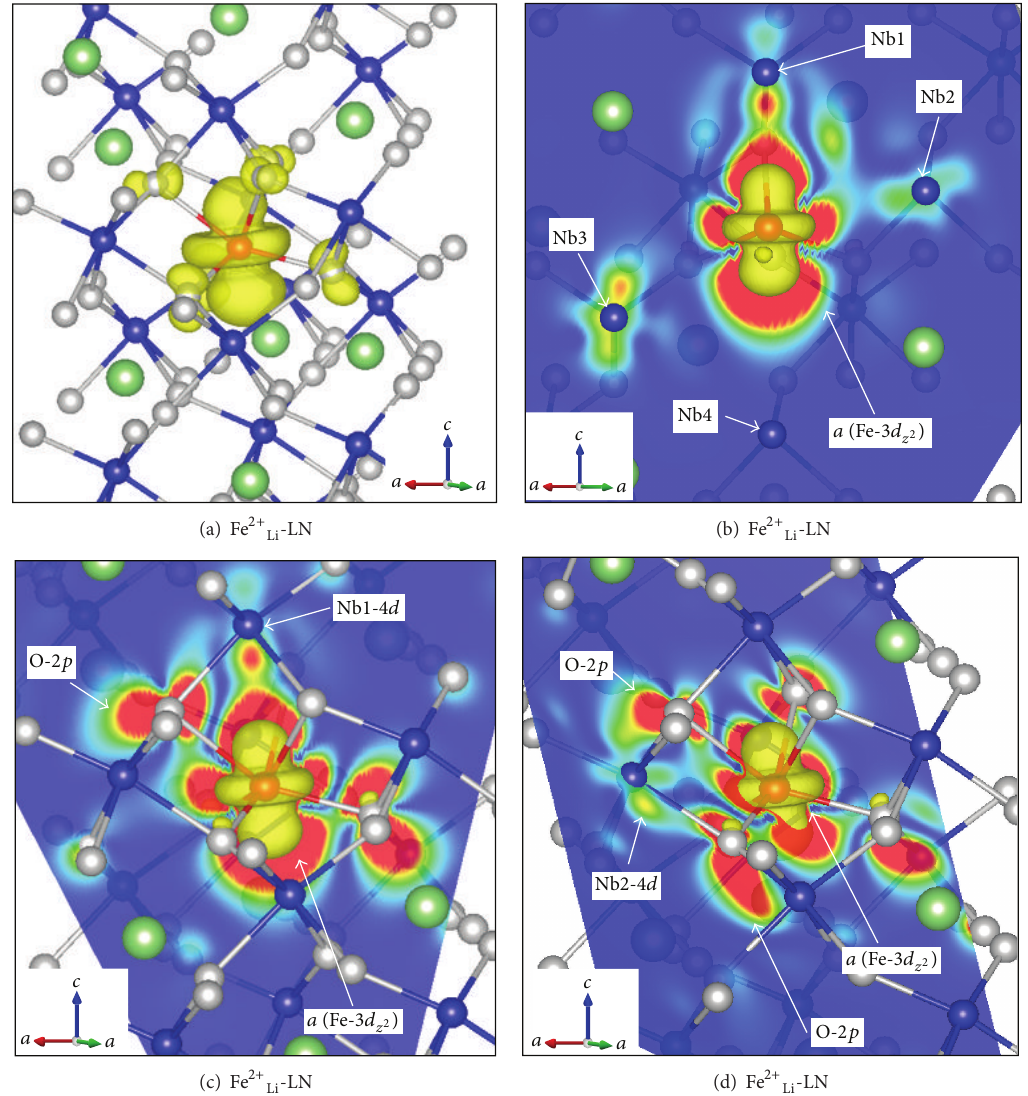
Figure 4: Wave functions of the occupied 𝑎 state in the minority spin ( ↓ ) band of the Fe 2+ -LN cell (a) in a three-dimensional view and its two-dimensional projections on the (b) Nb1-Fe-Nb3 (c) Nb1-Fe-O2 and (d) O2-Fe-O1